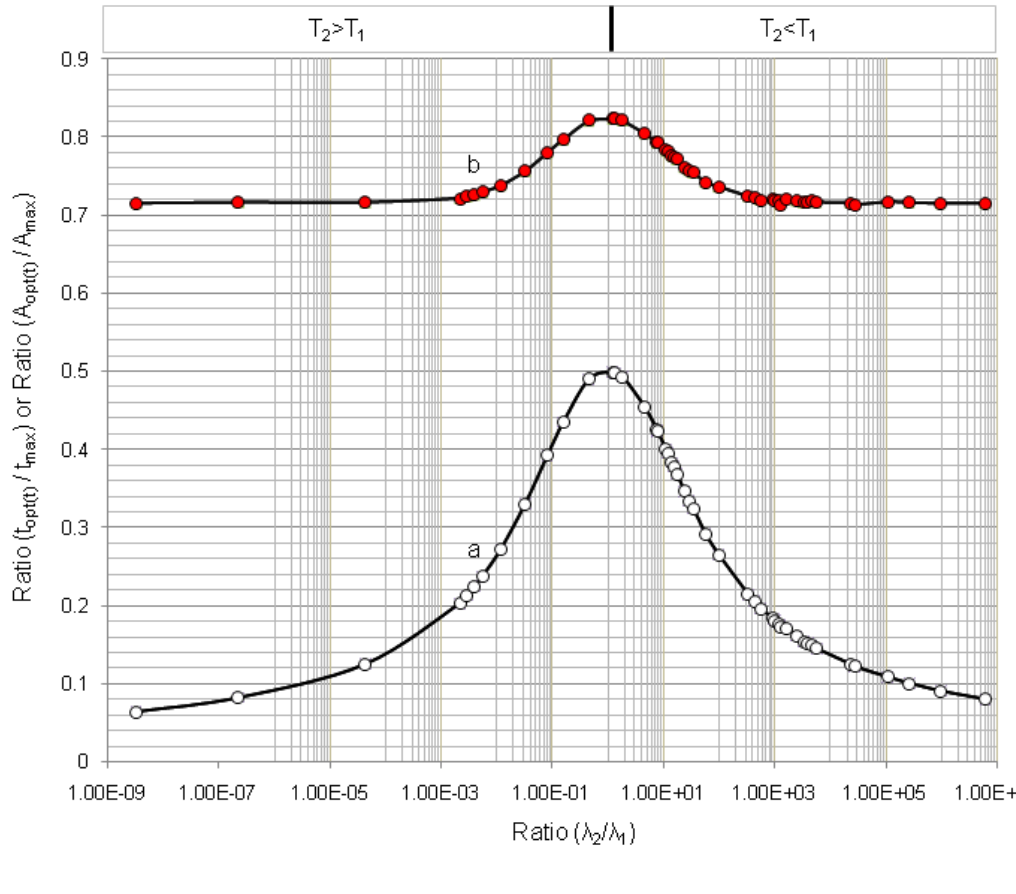
Figure 9. Optimal build-up time value t nuclides compared with values t ratio ( λ / λ ): (a) Ratio ( t 2 1 of the parent and daughter nuclides,